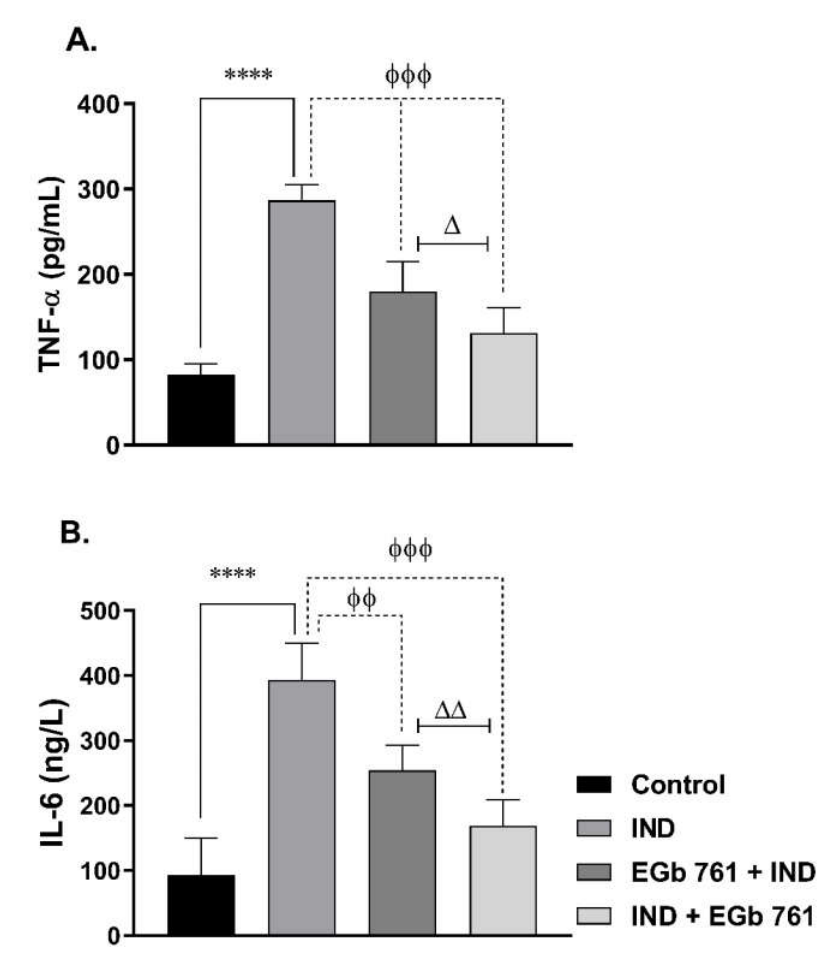
Figure 3. The effects of administration of indomethacin and EGb 761 on the gastric tissue levels of TNF-α ( A ) and IL-6 ( B ). Data are presented as mean ± SEM (n = 6). **** ( p < 0.0001) significantly different from control. φφ ( p < 0.01) and φφφ ( p < 0.001) significantly different from the IND group. ∆ ( p < 0.05) and ∆∆ ( p < 0.01) significantly different from EGb 761 + IND (Prophylactic EGb 761) group. IND: Indomethacin; EGb 761: Standardized G. biloba